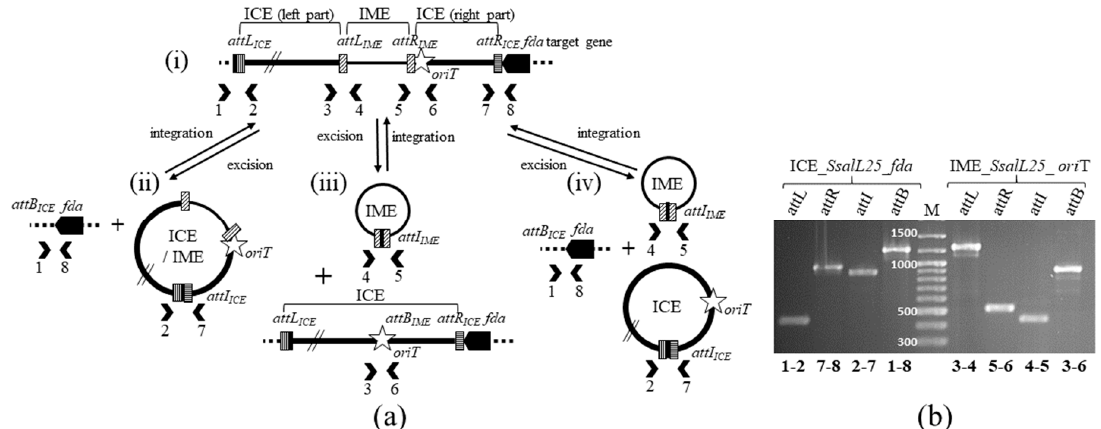
Figure 2. Excision of IME_ SsalL25_oriT and its hosting ICE (ICE_ SsalL25_fda ) in S. salivarius L25. ( a ) Diagram showing the localization of PCR primers (numbered chevrons) used to detect (i) integrated forms of elements ( attR and attL for right and left junctions, respectively) and excised forms ( attI for circular form of the integrative elements and attB for the bacterial empty site) if (ii) the ICE/IME composite element excises, (iii) only the IME excises or (iv) both elements excise separately; ( b ) PCR products obtained with the primer pairs (numbers indicated at the bottom of the gel) when analyzing excision of IME_ SsalL25_oriT and of its hosting ICE (ICE_ SsalL25_fda ). The sizes of the PCR fragments were confirmed by parallel migration of a DNA ladder (M for marker on the figure). The primers pairs used for these amplifications and expected sequence lengths are listed in Table